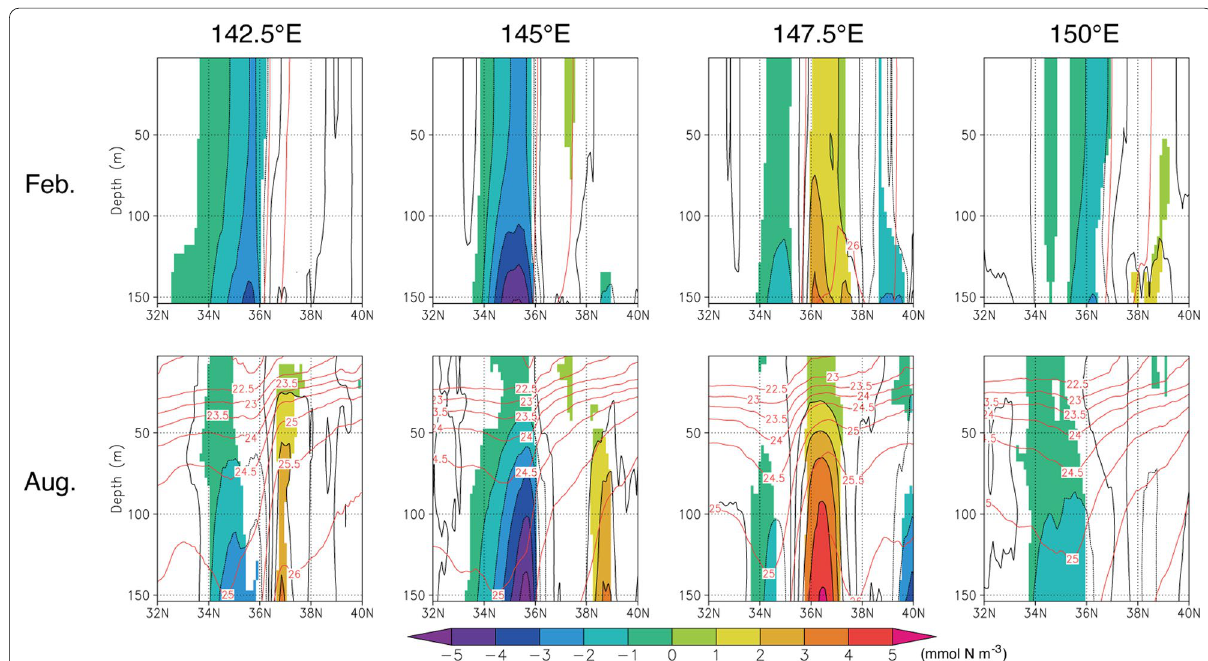
Fig. 9 Composites of nitrogen concentration anomalies (in mmol N m − 3 ) along (left to right) 142.5°E, 145°E, 147.5°E, and 150°E during the stable states in (upper row) February and (bottom row) August. The contour intervals are 1 mmol N m − 3 . Also shown with red contours are composites of potential density. Anomalies significant at the 95% confidence level by a two-tailed t test are shaded